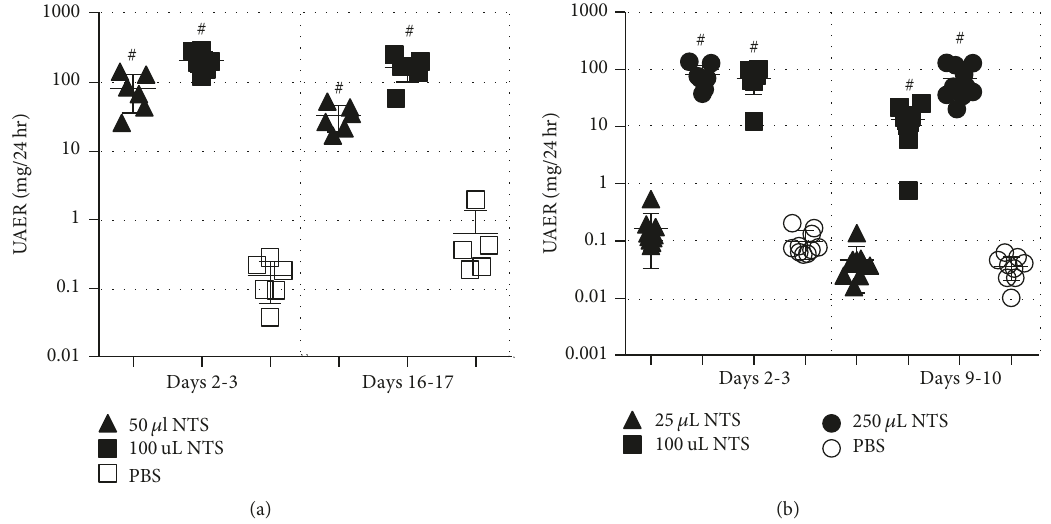
Figure 2: CD1 mice are more susceptible to NTS measured by albuminuria compared to C57BL/6 mice . (a) Scatter plot showing the 24 h urinary albumin excretion rate (UAER) of CD1 mice over time. (b) Scatter plot showing the 24 h urinary albumin excretion rate (UAER) of C57BL/6 mice over time. Data are shown as mean ± SD. # 𝑃 < 0.0001 NTS groups ( 𝑛 = 5 -6) versus PBS group ( 𝑛 = 5 -6) by one-way ANOVA.